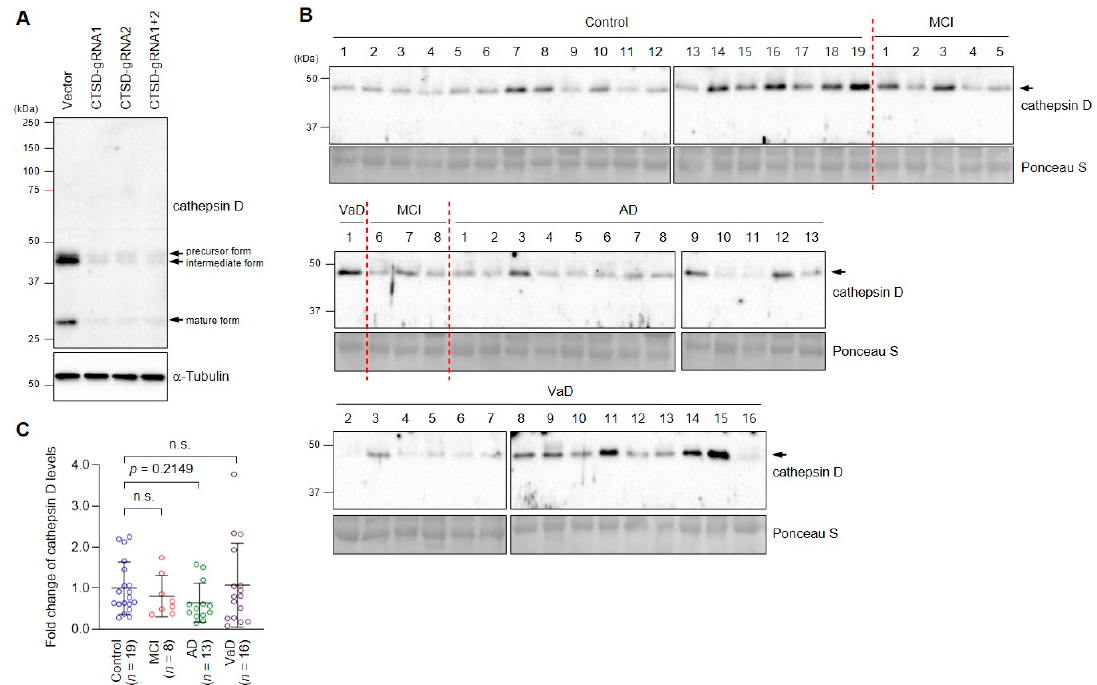
Figure 2. Immunoblotting analysis revealed that the level of cathepsin D decreased in the AD patient plasma. ( A ) Validation of the cathepsin D antibody for immunoblot analysis. HeLa cells were transfected with an empty vector (Vector) or vectors with gRNAs specific to the CTSD gene (CTSD-gRNA1, CTSD-gRNA2, CTSD-gRNA1+2), and lysates were immunoblotted with the indicated antibodies. ( B ) Analysis of the cathepsin D level of plasma samples from the control group and each patient group. Albumin/IgG-depleted plasma samples were immunoblotted with a cathepsin D antibody. Ponceau S staining was performed after SDS-PAGE to show that equal amounts of plasma proteins were loaded in each lane. ( C ) The band intensities of cathepsin D (B, arrow) in each patient group were compared to those of the control group. Each colored dot indicates the cathepsin D level of plasma samples from each patient, which was analyzed by immunoblotting. Mean ± SD was illustrated as a horizontal line in each group. The p -value was calculated using the Kruskal–Wallis test, followed by Dunn’s multiple comparisons test. n.s., not significant. Arrows indicate specific bands of cathepsin D. Molecular weight standards (in kDa) are shown to the left.